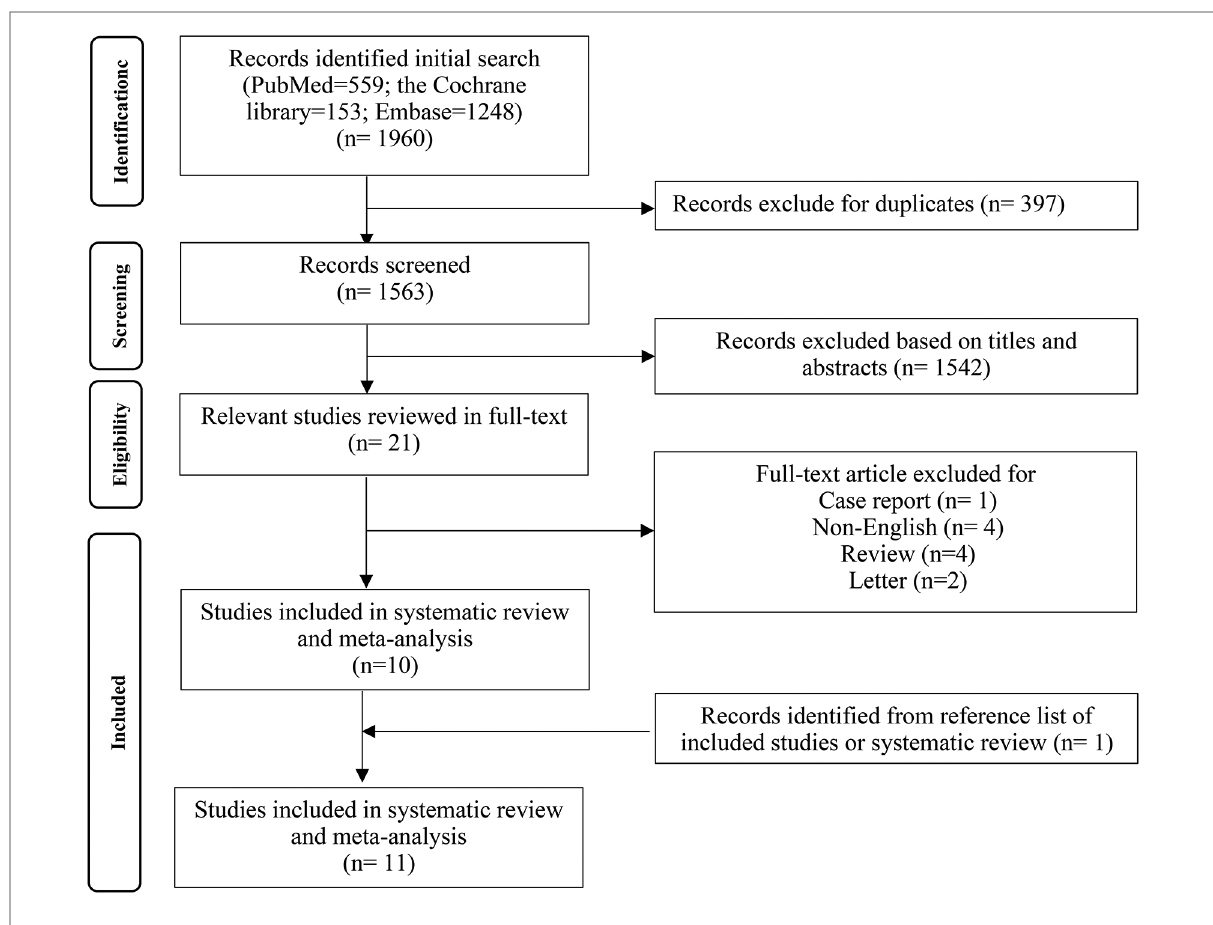
FIGURE 1 Flow diagram depicting the search strategy and study selection process.